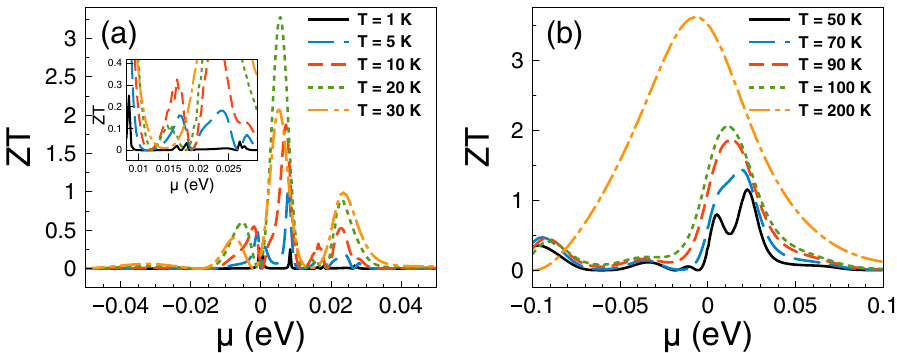
Figure 19. The same as Fig. 12, but for d B = d W = 10 nm. Here, the charge neutrality point and Breit–Wigner resonances shape the ZT characteristics at low temperatures, while the contribution of hybrid resonances become preponderant at the temperature rises, merging as a single broad peak at high temperatures.